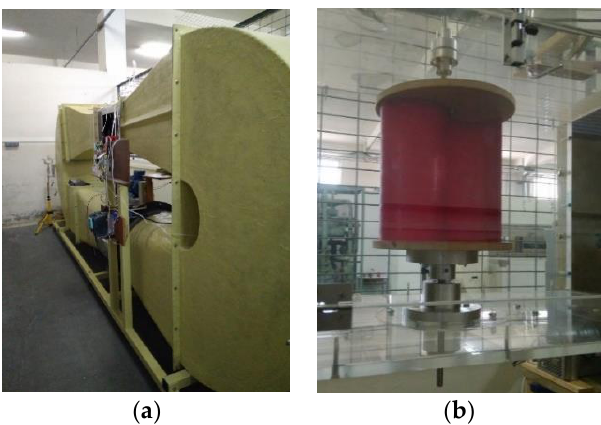
Figure 6. ( a ) Wind tunnel used for the measurements; ( b ) turbine inside the test